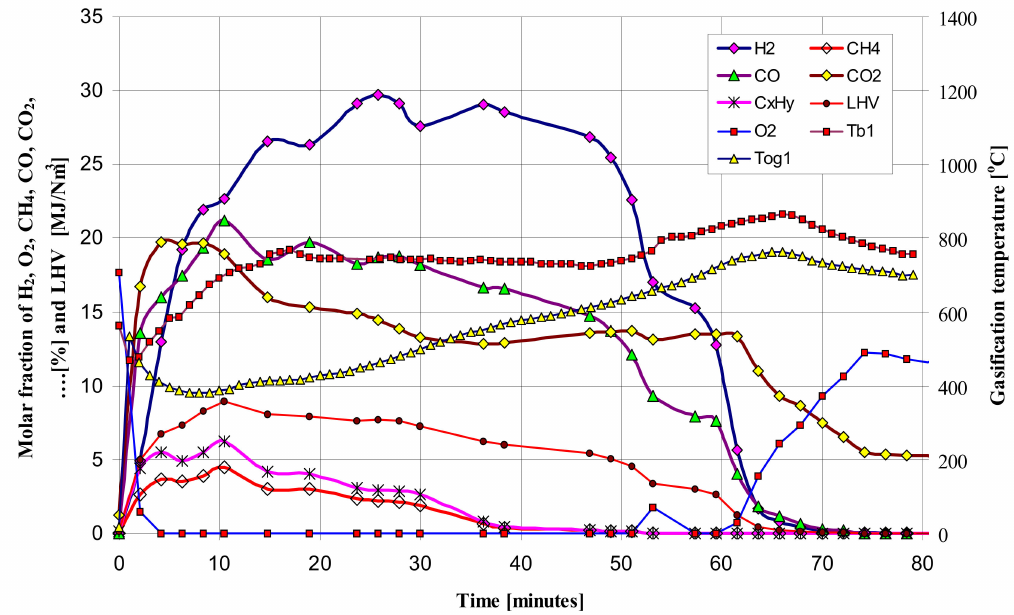
Figure 4. Changes of the dry fuel gas components (H 2 , CO, C m H n , CH 4 , CO 2 ), LHV, gasifier bed temperature (T b1 ) and the exit dry fuel gas (T og1 ) temperature versus gasification process time. Feed gas composed of mixture of air (17%) and steam (83%) preheated to 900 ◦ C with volumetric flow rate equal to 56 Nm 3 /h (gasification of 20 kg of 12 mm wood